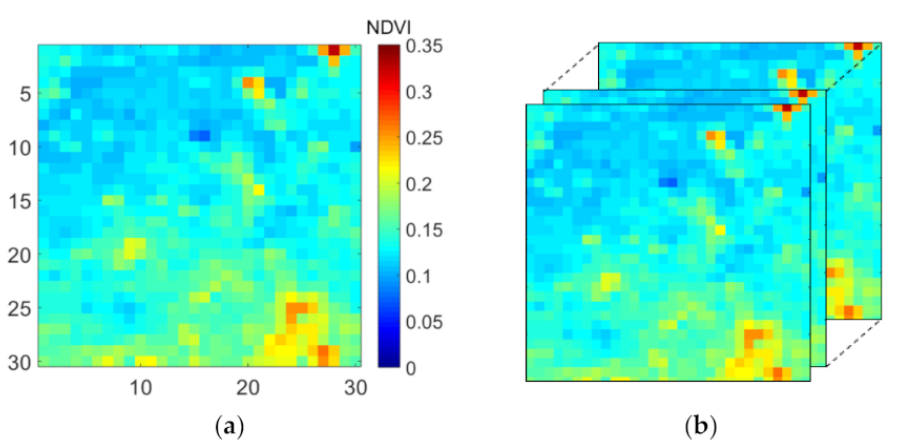
Figure 3. A single time frame from study region 1 corresponding to 23 January is shown in ( a ). This particular day was selected because it contained no missing data. The chosen frame was replicated